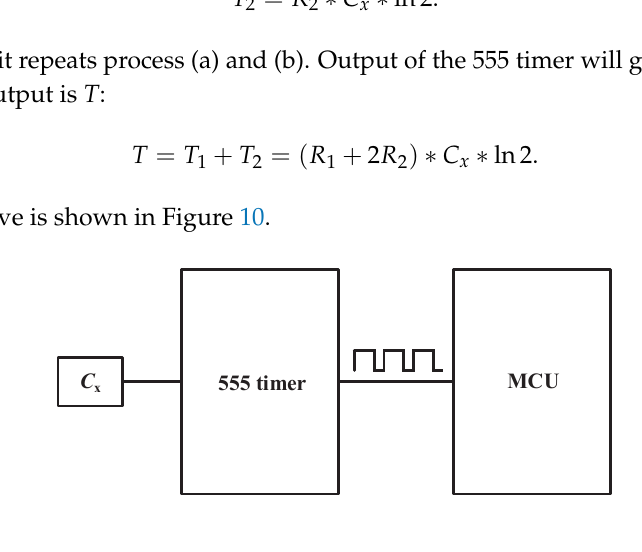
Figure 9. Measurement circuit of a fringing electric field